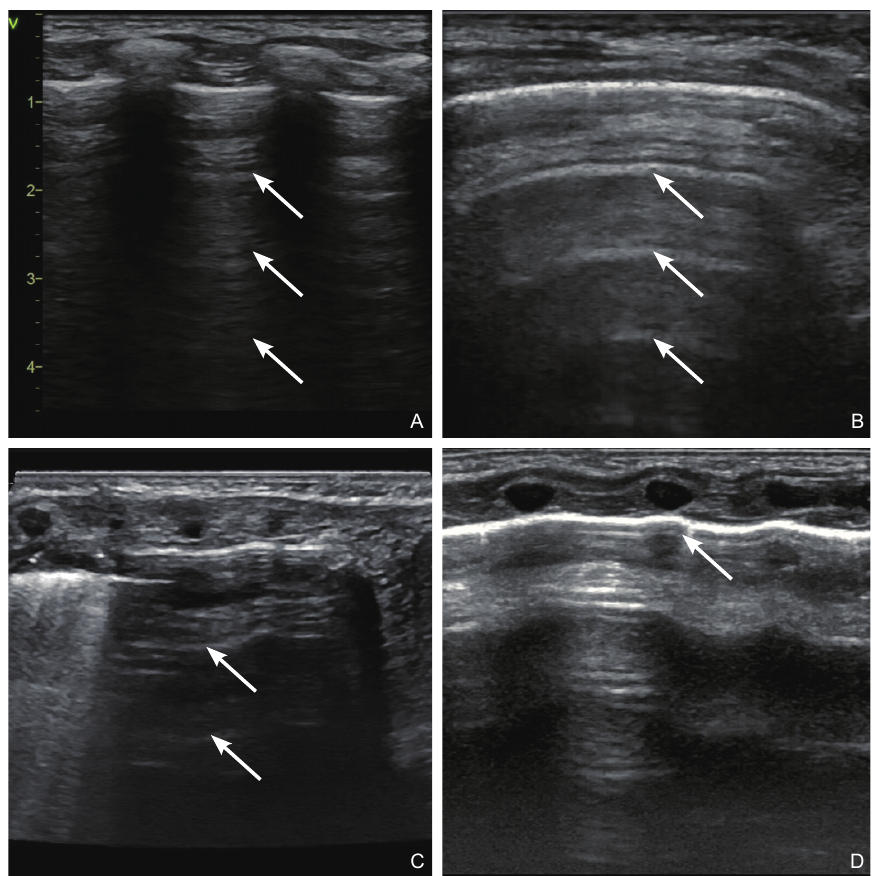
Figure 3 A-lines. (A ~ B) Normal pulmonary sonogram; (C ~ D) pneumothorax. (A) Transthoracic transverse section, the arrow is shown as A-line; (B) Transthoracic longitudinal section, the arrow is shown as A-line; (C) A-line of gas formation in pleural cavity (arrow); (D) Sporadic B line (arrow) indicates that A-line originates from the